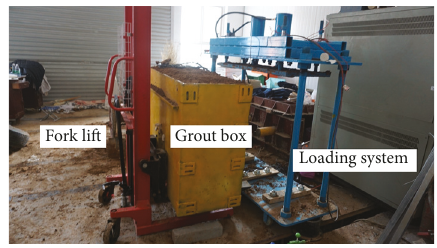
Figure 1: Grouting